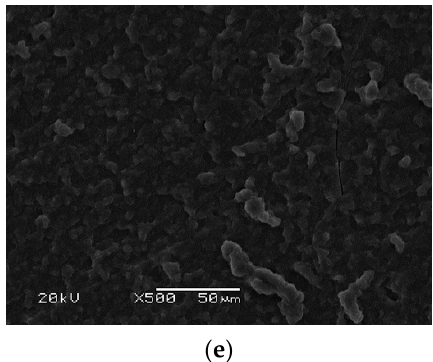
Figure 6. Morphology analysis of the HAp powders and composite materials before the incubation period: ( a ) SEM images of hydroxyapatite obtained by method A; ( b ) SEM images of hydroxyapatite obtained by method B; ( c ) SEM image of the WPI/HAp A5 composite; ( d ); SEM image of the WPI/HAp B5 composite; ( e ) SEM image of a pure WPI hydrogel matrix.